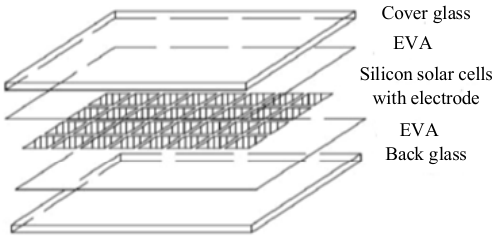
Figure 3. The cross-section of the solar panel [ 19].